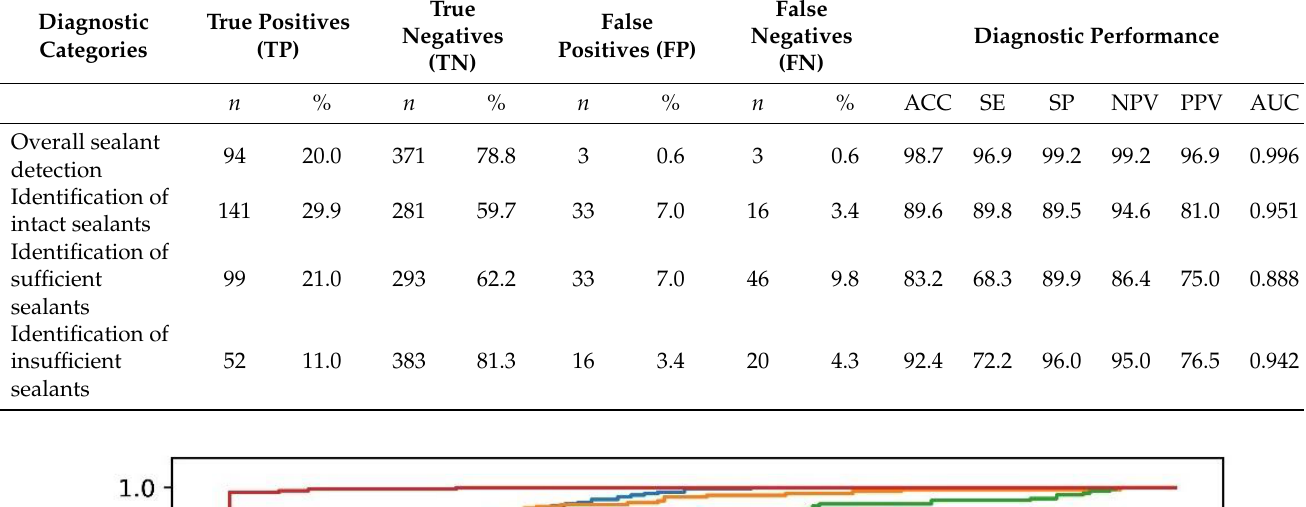
Table 1. Overview of the diagnostic performance of the developed convolutional neural network (CNN), where the independent test set ( n = 471) was compared against independent expert evaluation of the caries detection level. The calculations were performed for different types of teeth, surfaces and training steps. In this context, the overall diagnostic accuracy (ACC), sensitivity (SE), specificity (SP), negative predictive value (NPV), positive predictive value (PPV) and area under the receiver operating characteristic curve (AUC).